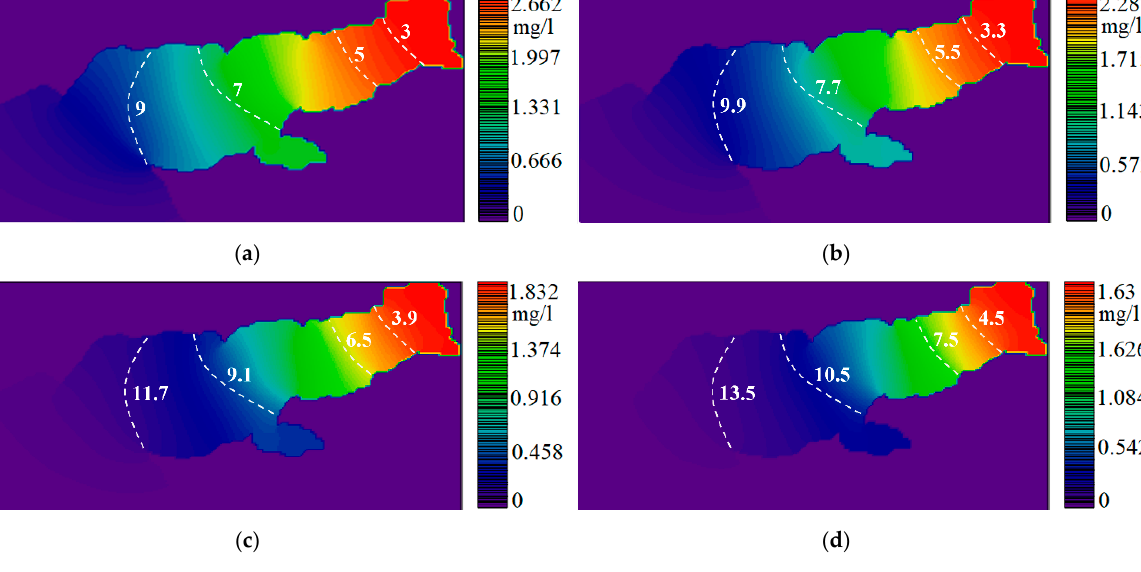
Figure 6. Distributions of green algae ( Chlorella vulgaris ) concentrations at different salinity levels: ( a ) initial; ( b ) increased by 10%; ( c ) increased by 30%; ( d ) increased by 50%.